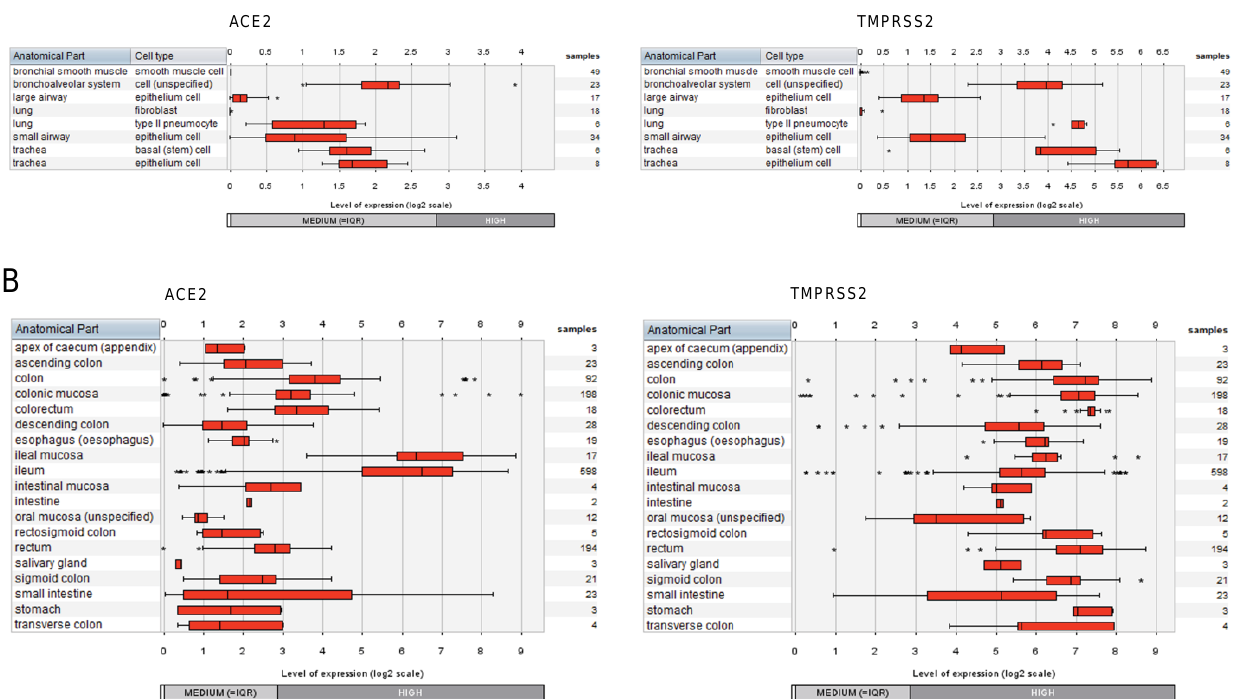
Figure 2. Expression patterns of ACE2 and TMPRSS2 across cell types and tissues of the respiratory and the gastrointestinal systems. The expression levels of ACE2 and TMPRSS2 were assessed by GENEVESTIGATOR-based compendium-wide analysis. ( A ) To extract the gene expression pattern, we applied the following filter on mRNASeq datasets: Anatomy > Cell Type > Respiratory System Cell (n = 167 datasets). The box plots represent the expression signature across various cell types from different anatomical parts of the respiratory system. Outliers are represented as stars. Anatomy > Tissue_Alimentary System > Gastrointestinal Tract (n = 1309 datasets). The box plots represent the expression signature across various tissue types of the gastrointestinal system. Outliers are represented as stars. The data were assessed and extracted from GENEVESTIGATOR on 13